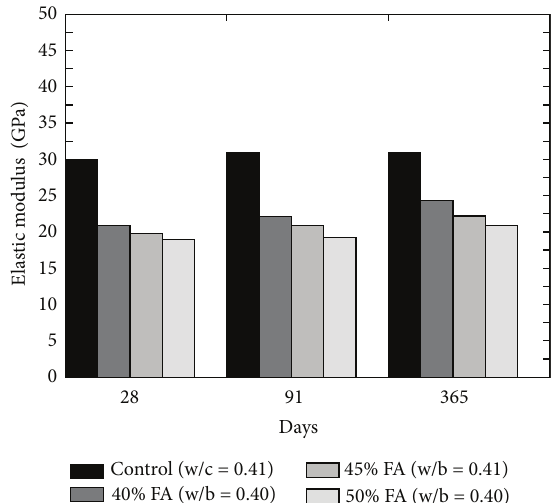
Figure 18: Effect of increasing FA content on the flexural strength [36].